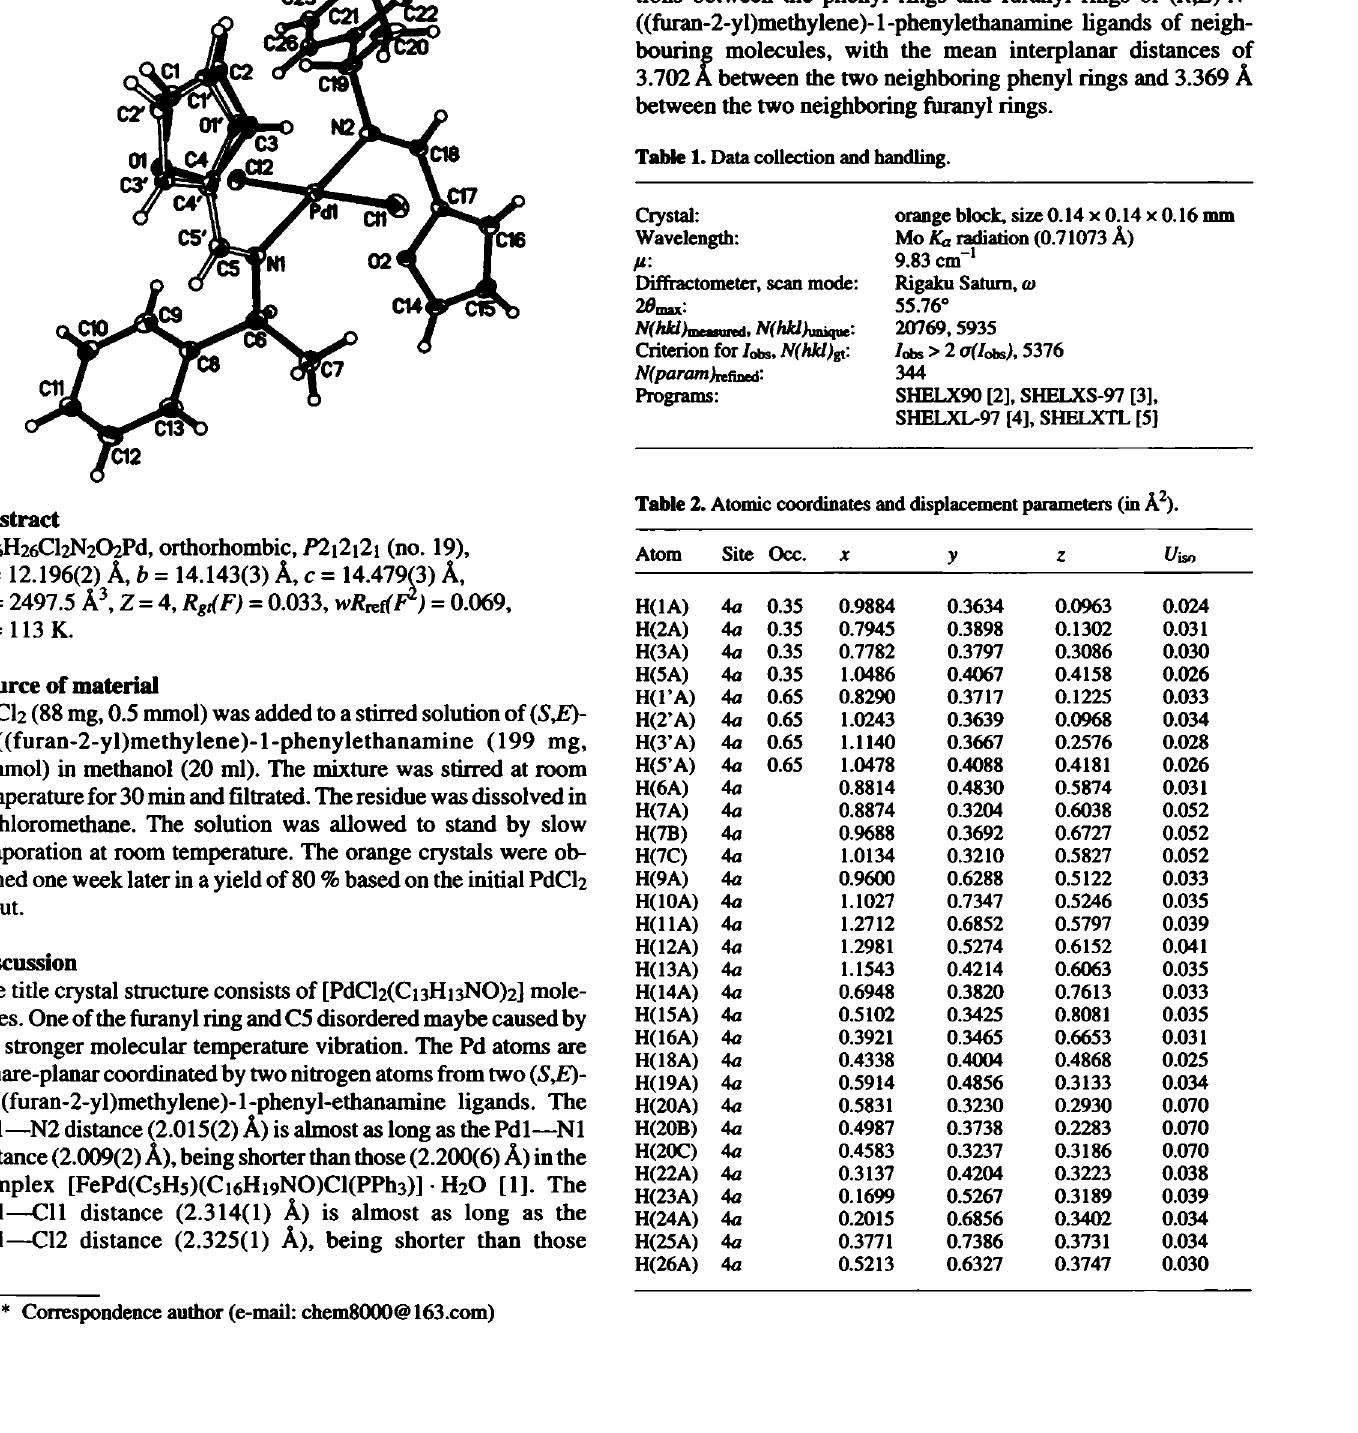
Table 1. Data collection and handling.